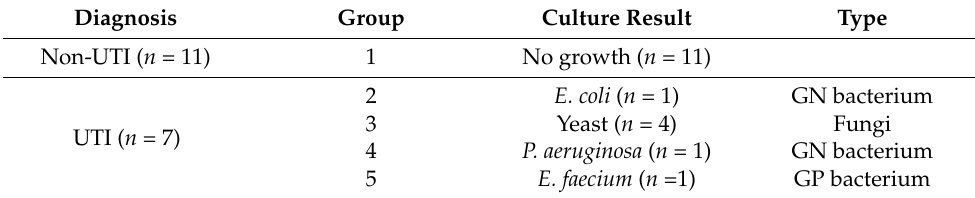
Table 1. Clinical characteristics of the urine samples ( n =